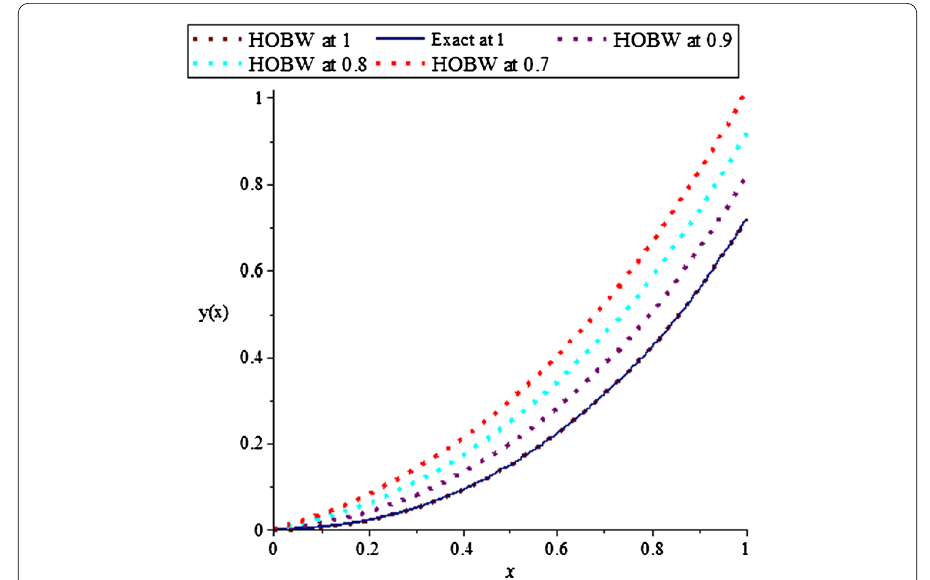
Figure 2 Numerical and exact solutions for different a for Example 7.1